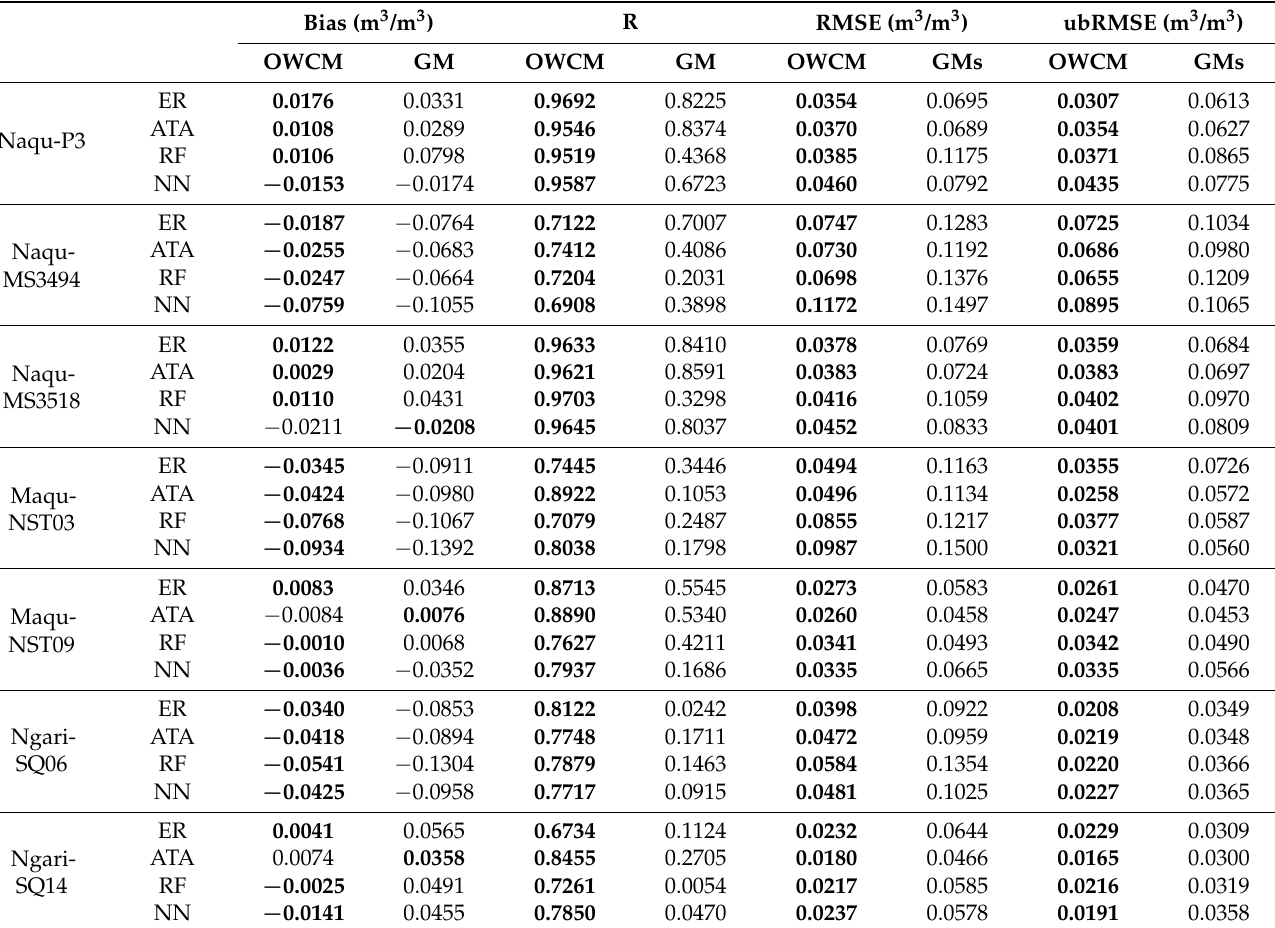
Table 3. Statistical metrics of GM-/OWCM-derived fine-RES SM datasets based on comparisons with in situ SM measurements. The superior metric within each pair of corresponding GM and OWCM products is indicated by bold